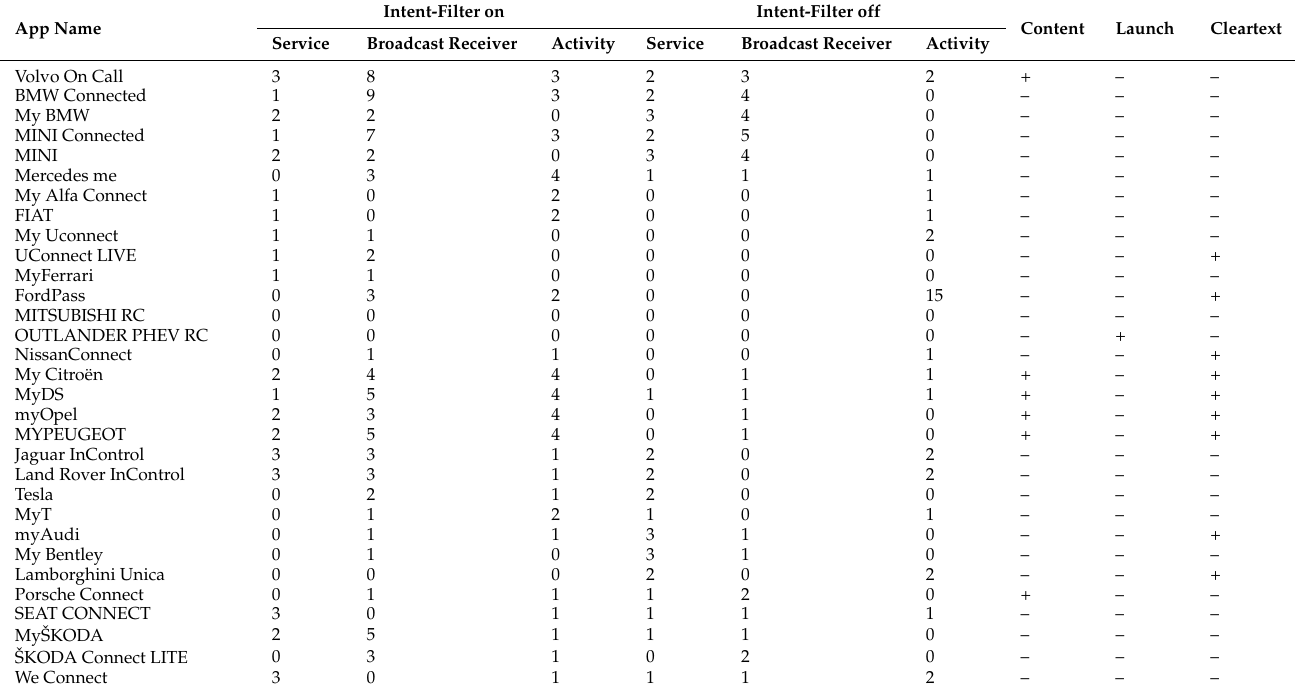
Table 7. Potentially vulnerable components in the manifest file of each